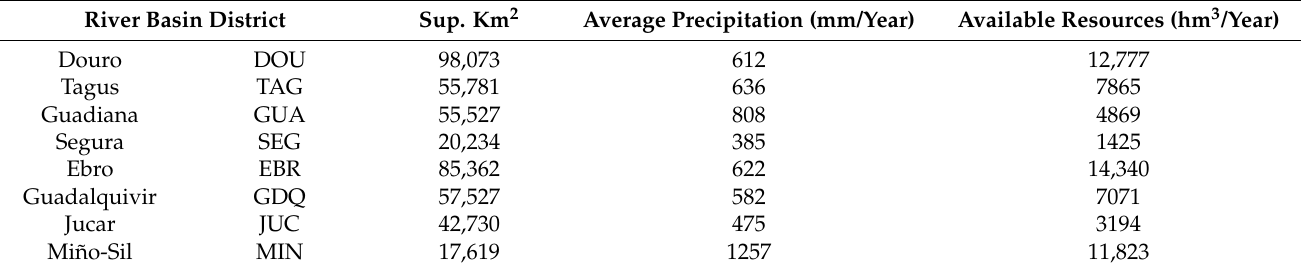
Table 2. Spanish River Basin Districts: DMPs overview.